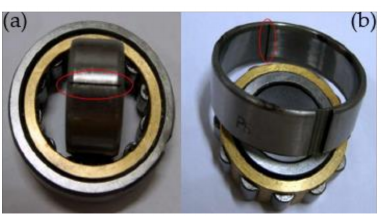
Figure 12. Type of rolling bearing failure. ( a ) is the inner-ring defect, ( b ) is the outer-ring defect.